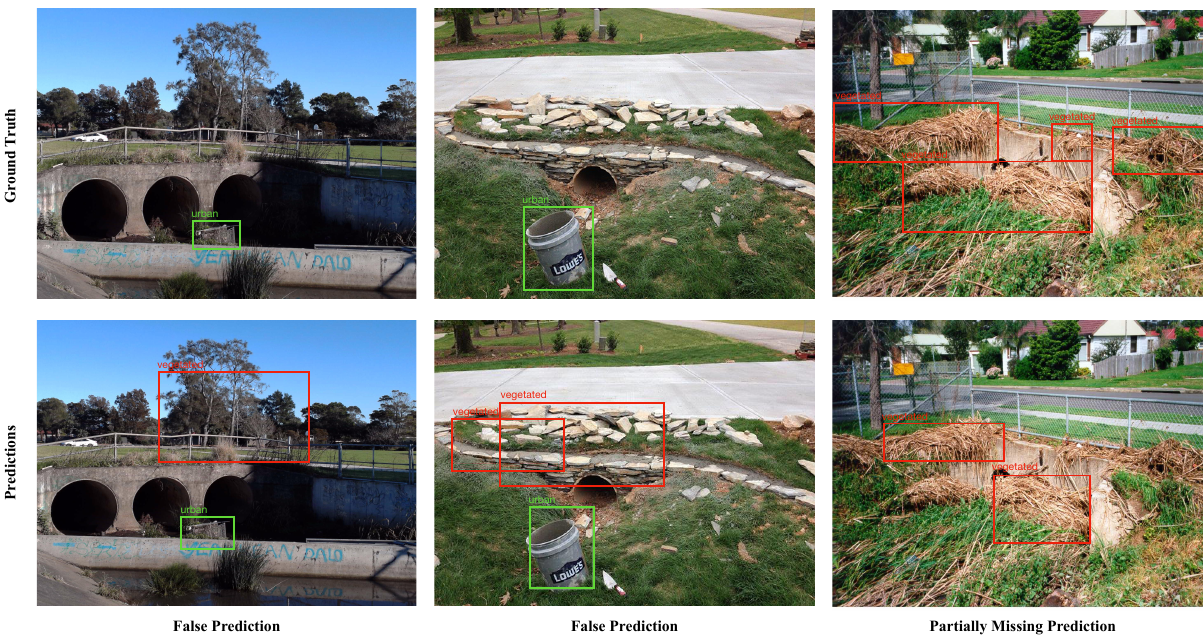
Figure 7. Sample of Correct Predictions by the Faster R-CNN with MobileNet Backbone Model.